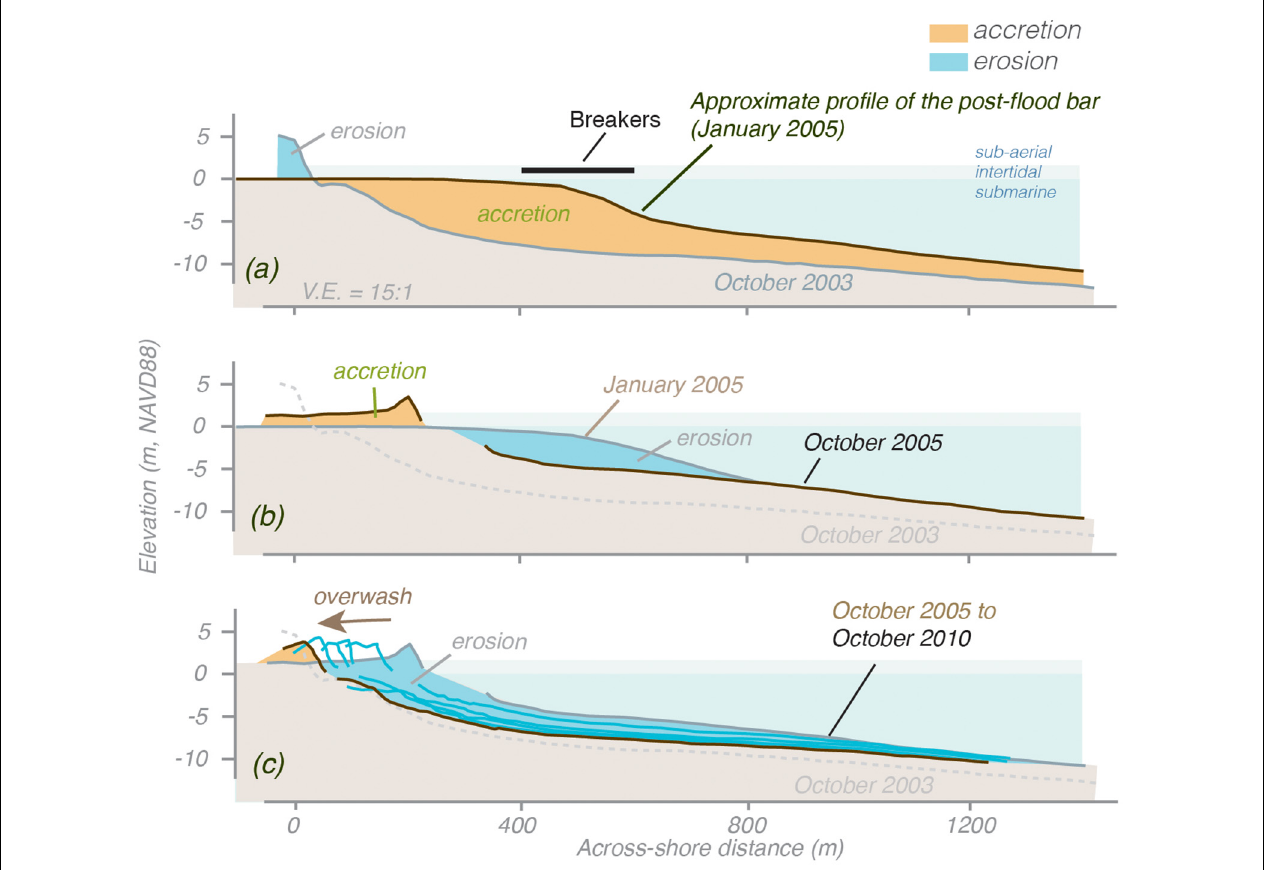
FIGURE 5 | Topographic and bathymetric profiles through the apex of the depositional sediment lobe offshore of the Santa Clara River, California for the January 2005 event shown in Figure 1 . (a) Before and immediately after profiles, where the January 2005 profile was approximated using the location of wave breaking and offshore bathymetric data as described by Warrick and Barnard (2012). (b) Post-deposition changes to the profile during the first year, and (c) changes for the following five years. Profile location is shown in Figure 2